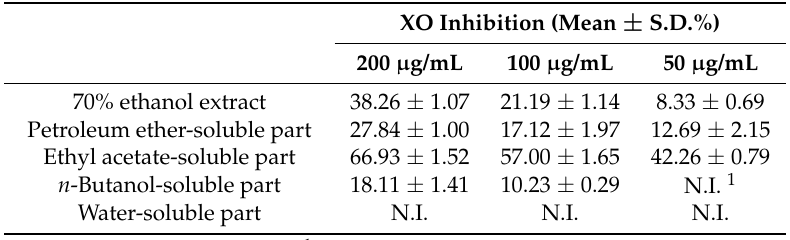
Table 1. XO inhibitory effects of the extract and soluble